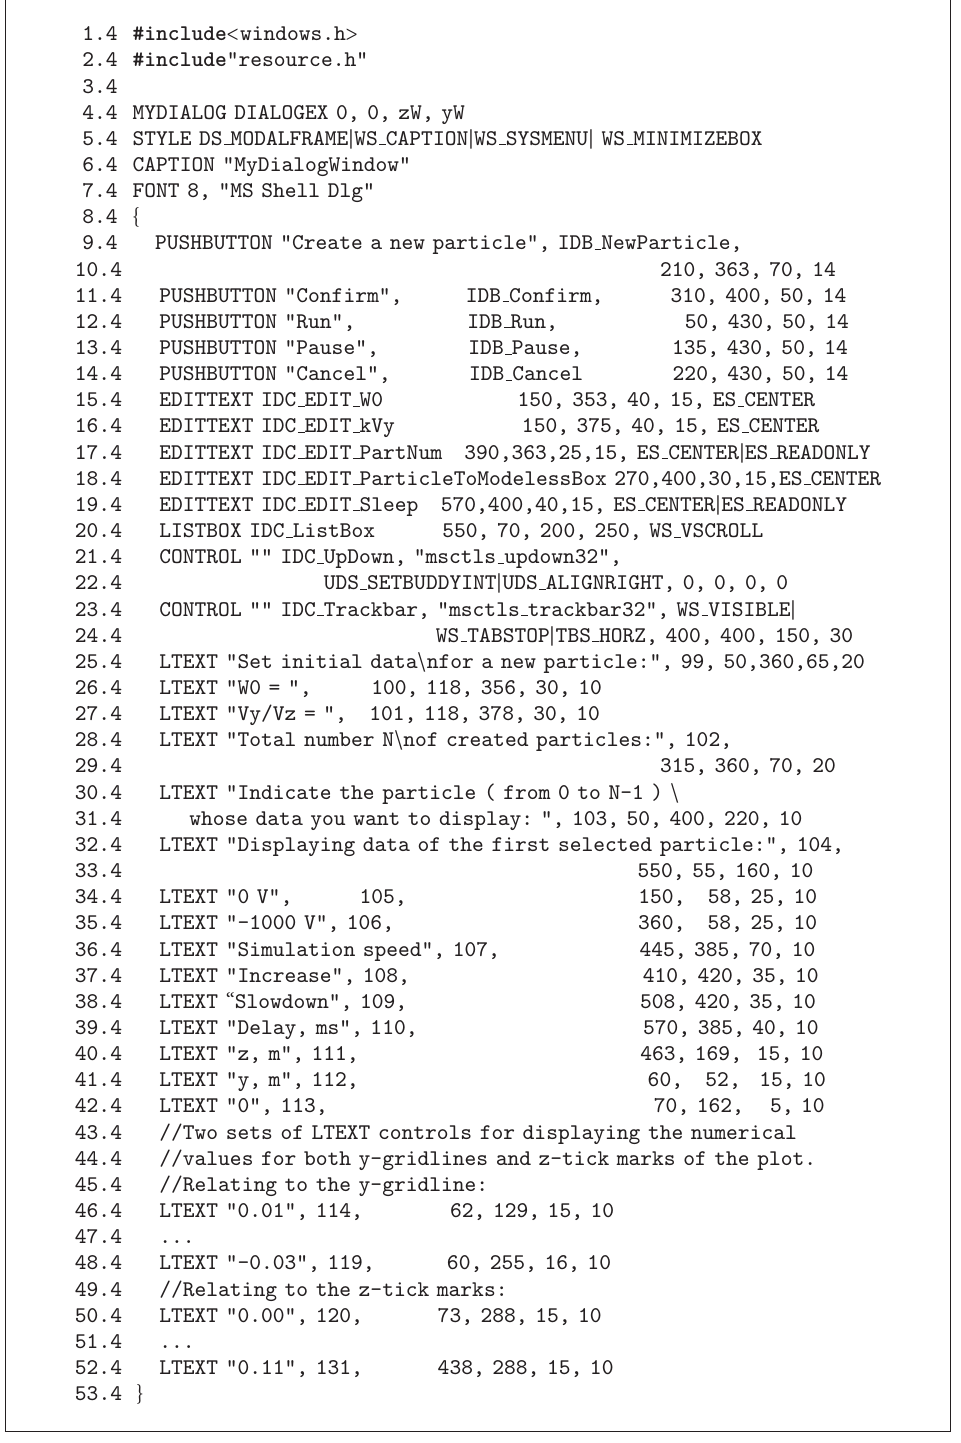
Algorithm 4: The resource script file script.rc for the modal